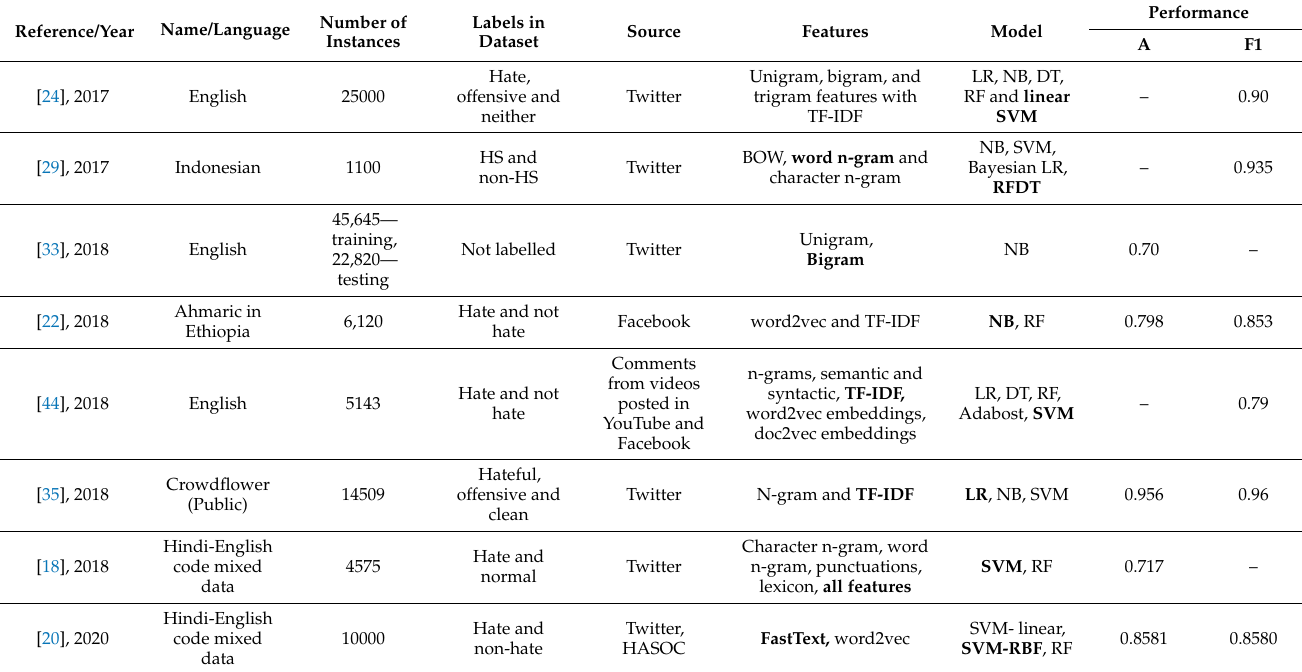
Table 16. Contemporary Hate speech Detection